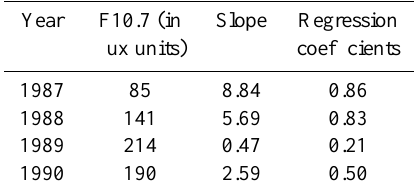
Table 1. Regression parameters for Fig.